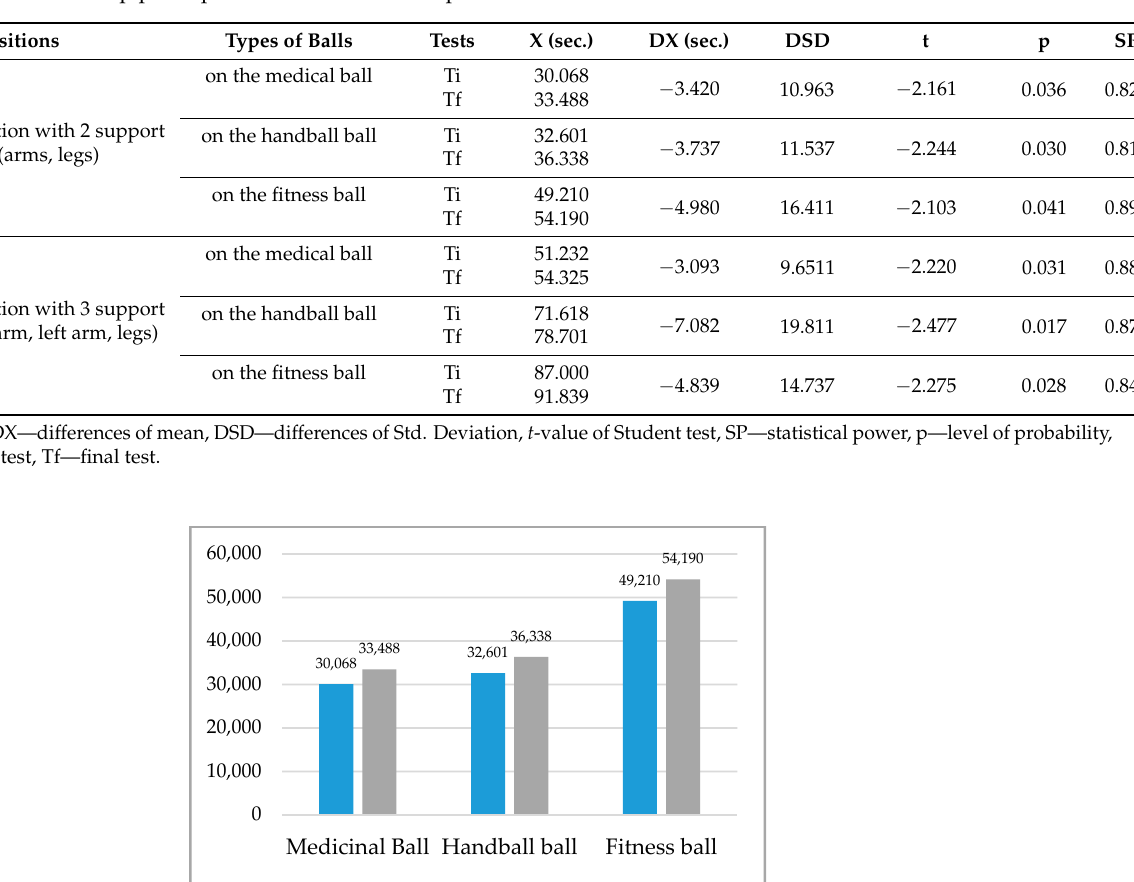
Table 2. Descriptive statistics of difference analyses between initial and final tests for maintaining balance test on the three types of balls in the up plank position—for whole sample.